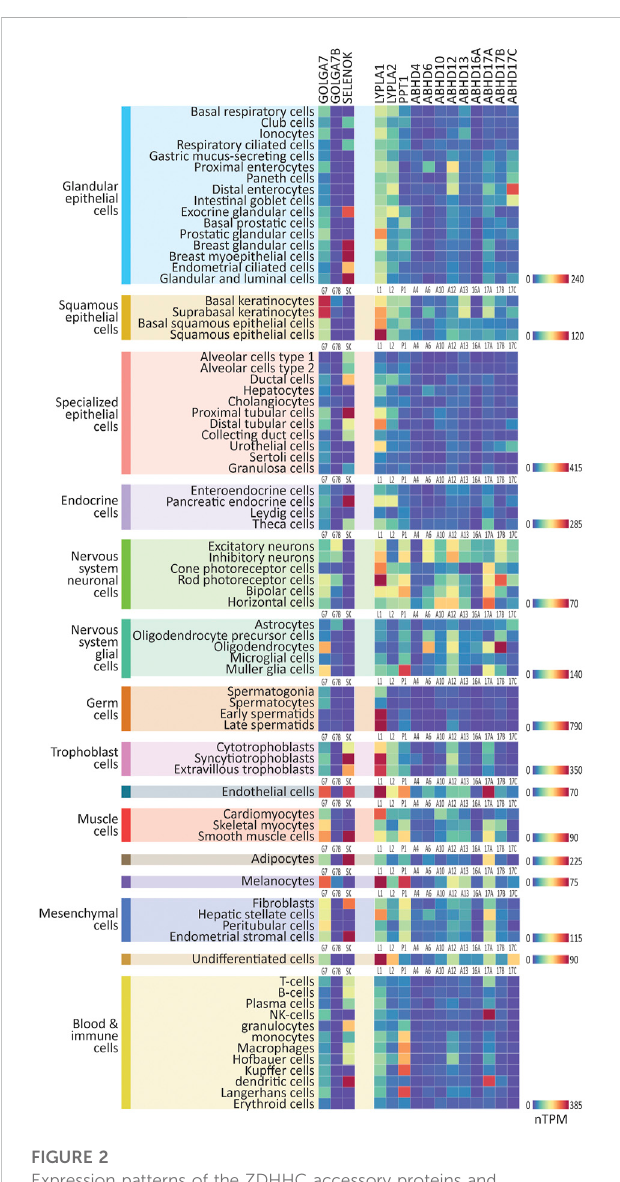
FIGURE 2 Expression patterns of the ZDHHC accessory proteins and depalmitoylating enzymes in major human cell types. Heatmaps showing human single-cell RNAseq expression data for the ZDHHC accessory proteins and depalmitoylating enzymes, downloaded from the Human Protein Atlas. 76 major cell types were identi fi ed within 15 cell type clusters. Heatmaps are grouped according to cell type cluster to view relative expression. Heatmap units: Transcripts per million (TPM). All data available for download on